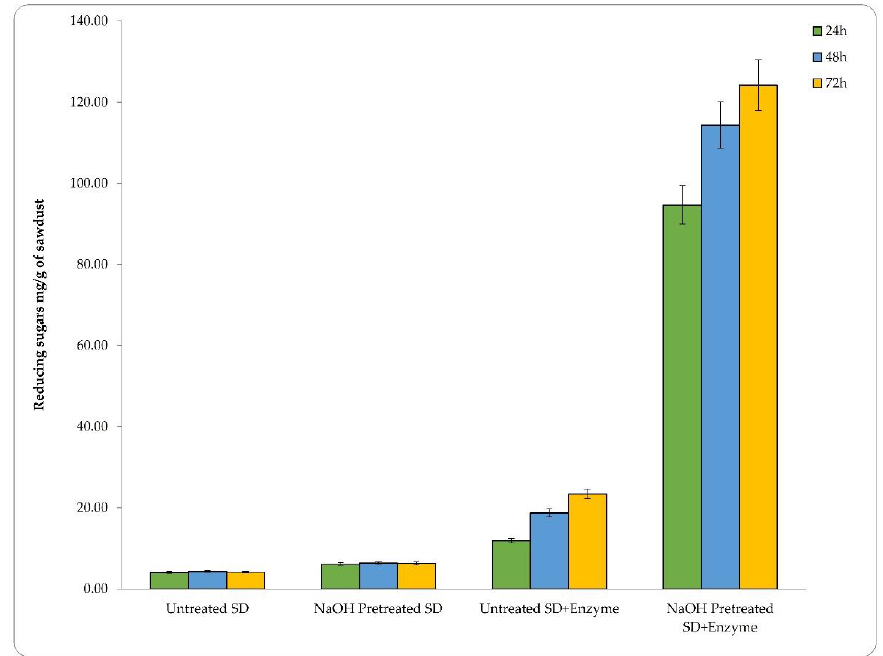
Figure 3. Reducing sugars obtained from untreated and NaOH-pretreated sawdust, with or without the fungal crude enzyme.